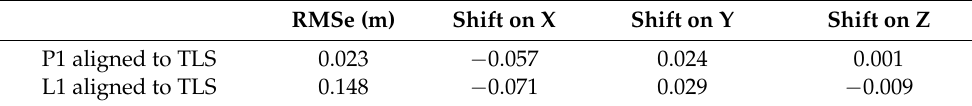
Figure 26. ICP alignment of Profile 3. Details of L1 (cyan) aligned with SX10 data (red): ( a ) before the alignment; ( b ) after the alignment. Table 14. Section no. 3—ICP registration and alignment: P1 and L1 data aligned with TLS cloud.